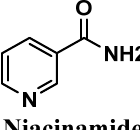
Figure 12. Chemical structure of